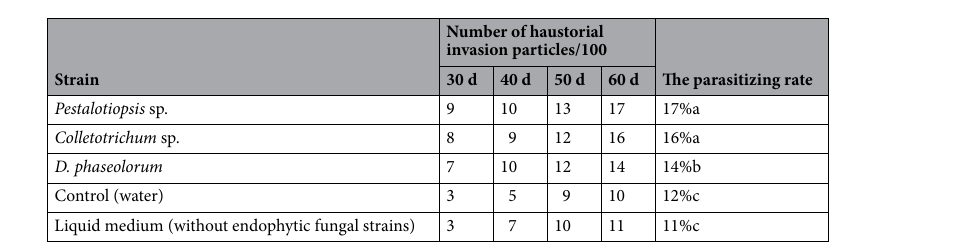
Table 3. Effects of endophytic fungi fermentation on parasitism rate of T. chinensis (indoor). Different lowercase letters in the same column represented significant difference ( P < 0.05).